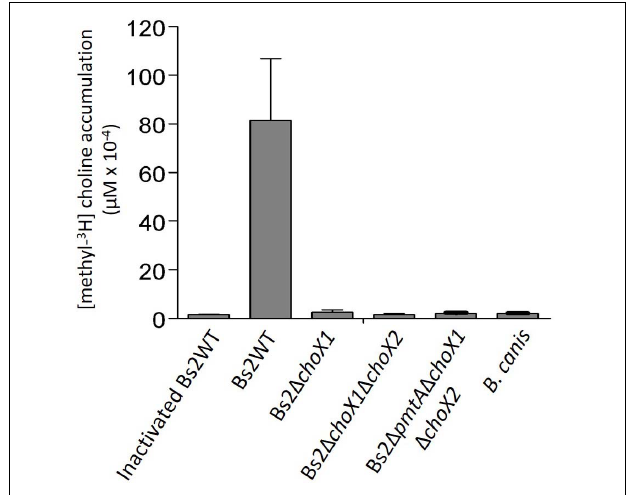
FIGURE 3 | Choline accumulation in Bs2WT, Bs2 (cid:49) choX1, Bs2 (cid:49) choX1 (cid:49) choX2 , Bs2 (cid:49) pmtA (cid:49) choX1 (cid:49) choX2 , and B. canis grown in mGSM. Values are the mean ± standard error of technical duplicates of a representative experiment, repeated at least two times with similar results.